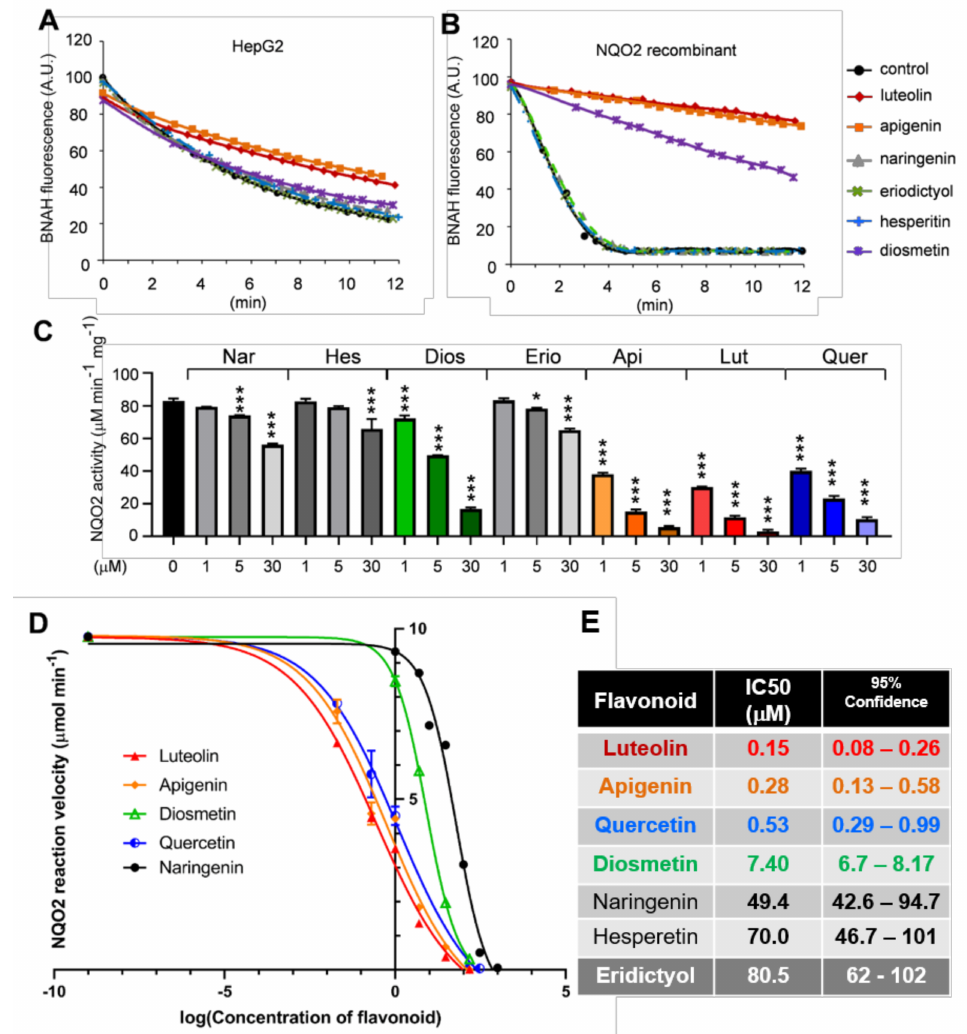
Figure 2. Inhibitory activity of Citrus polyphenols on NQO2 correlates with their pro-autophagic activity. Fluorimetric determination of NQO2 co-substrate (BNAH) oxidation in the presence of different sources of NQO2: ( A ) HepG2 cells (5 µ g/well) and ( B ) purified human recombinant NQO2 (hNQO2, 10 ng per well) and 5 µ M of flavonoids. Experimental points and best-fitted curves to are shown. ( C ) Flavones and flavonol quercetin are the best inhibitors of NQO2 activity. The reactions were carried out as described above in the presence of polyphenols at indicated concentrations and NQO2 activity was calculated. The graph shows the mean ± SEM of an experiment performed in triplicate. Statistical analysis: one-way ANOVA followed by Dunnett test; * p < 0.05, *** p < 0.001; significantly different from control. ( D ) The enzyme inhibition curves for hNQO2 used to calculate IC 50 values. The curves for five inhibitors are shown. ( E ) IC50 values calculated for the assays as in C and